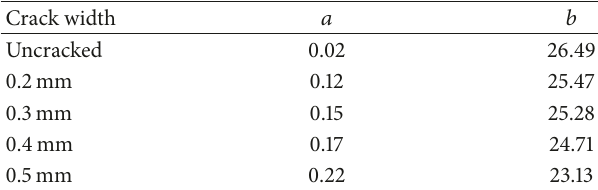
Table 3: The coefficients 𝑎 and 𝑏 for variable crack width in (5). Crack width